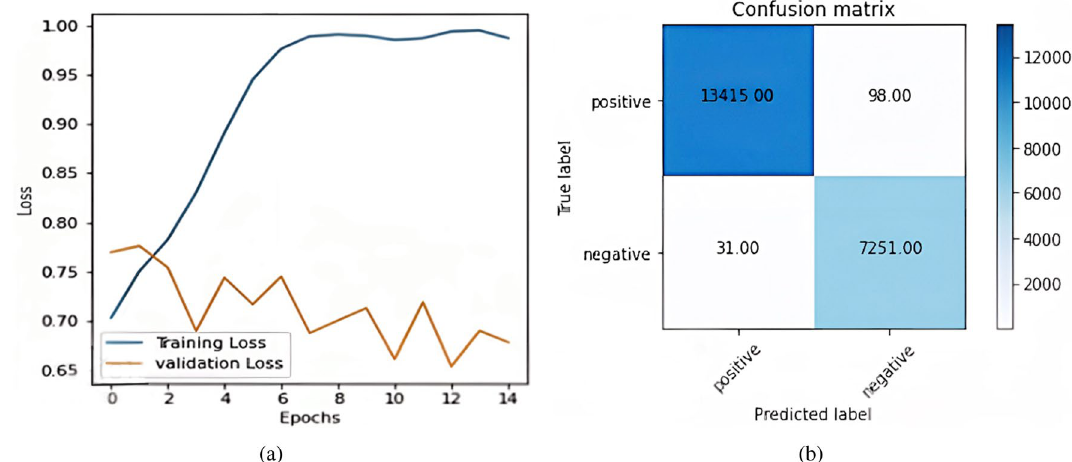
Figure 6. BERT Plus CNN ( a ) BERT plus CNN accuracy curve; ( b ) Confusion matrix BERT plus CNN.